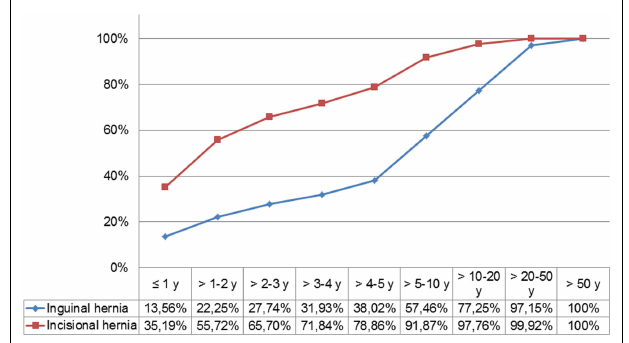
FIGURE 1 | Time line between previous and recurrent inguinal and incisional hernia repair